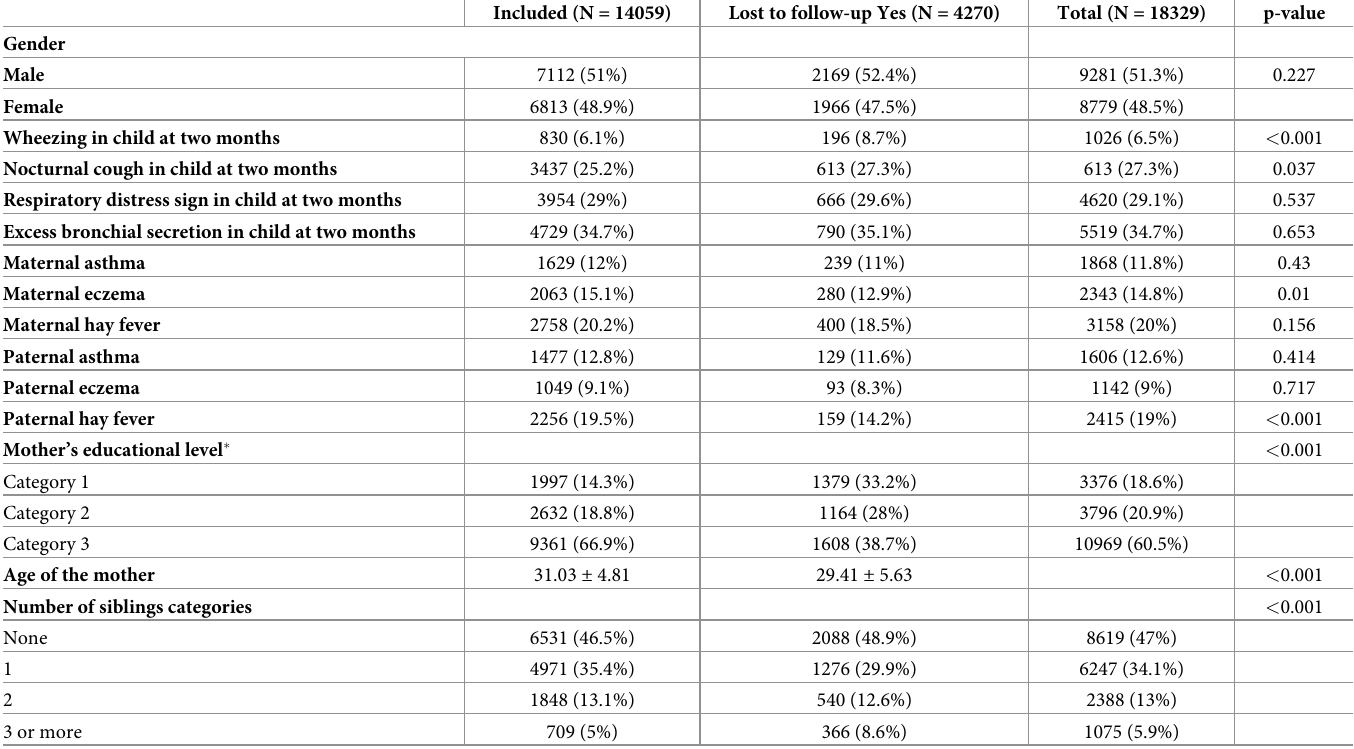
Table 2. Comparison between children at one year and children lost to follow-up in ELFE cohort.